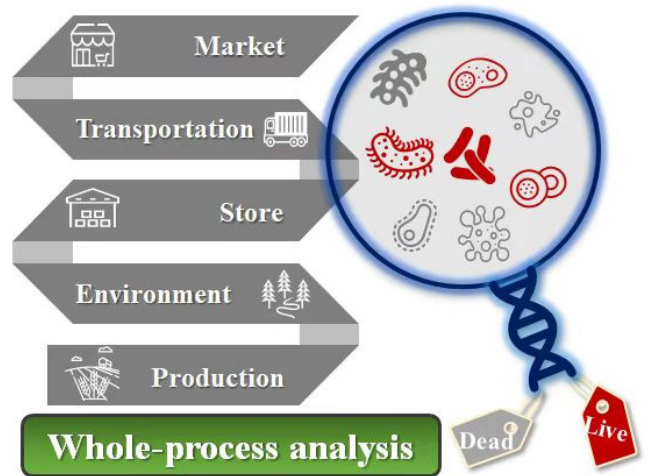
Figure 3. Graphics of the whole process of PCR-mediated nucleic acid molecular recognition technology applied to the detection of foodborne pathogens.